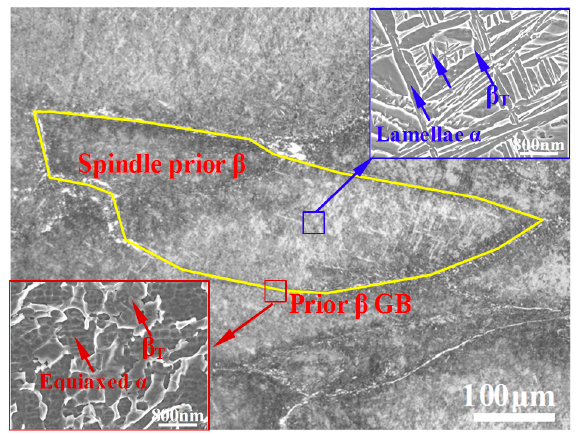
Figure 3. Microstructure of the hot-rolled titanium alloy.